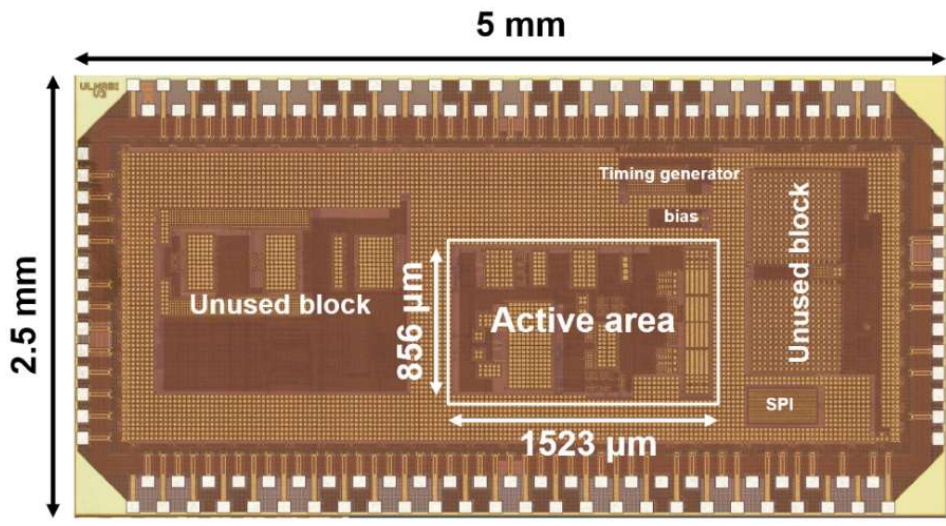
Figure 12. Die photograph of the proposed readout IC.